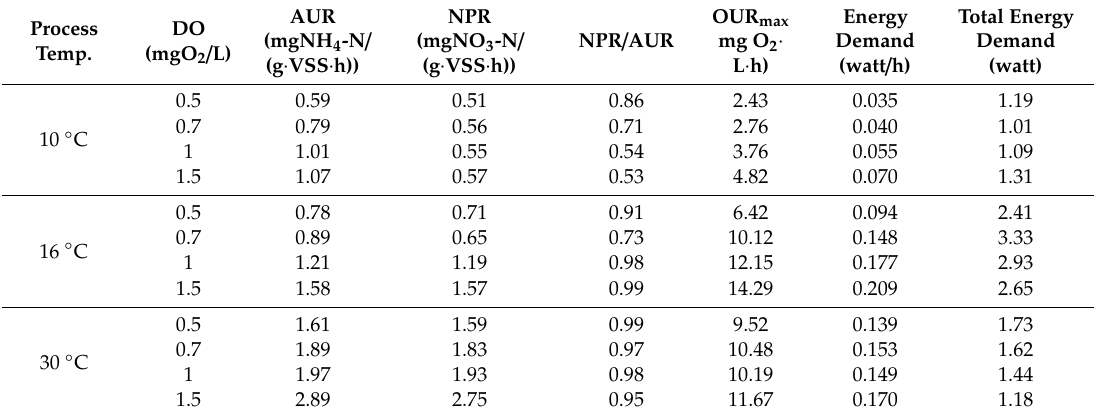
Table 2. Summary of the main criteria for the evaluation of the nitrification process based on the AOB-NOB activity at di ff erent temperatures and DO concentrations with ammonium as a sole nitrogen source (substrate limiting conditions for NOB). Process Temp.